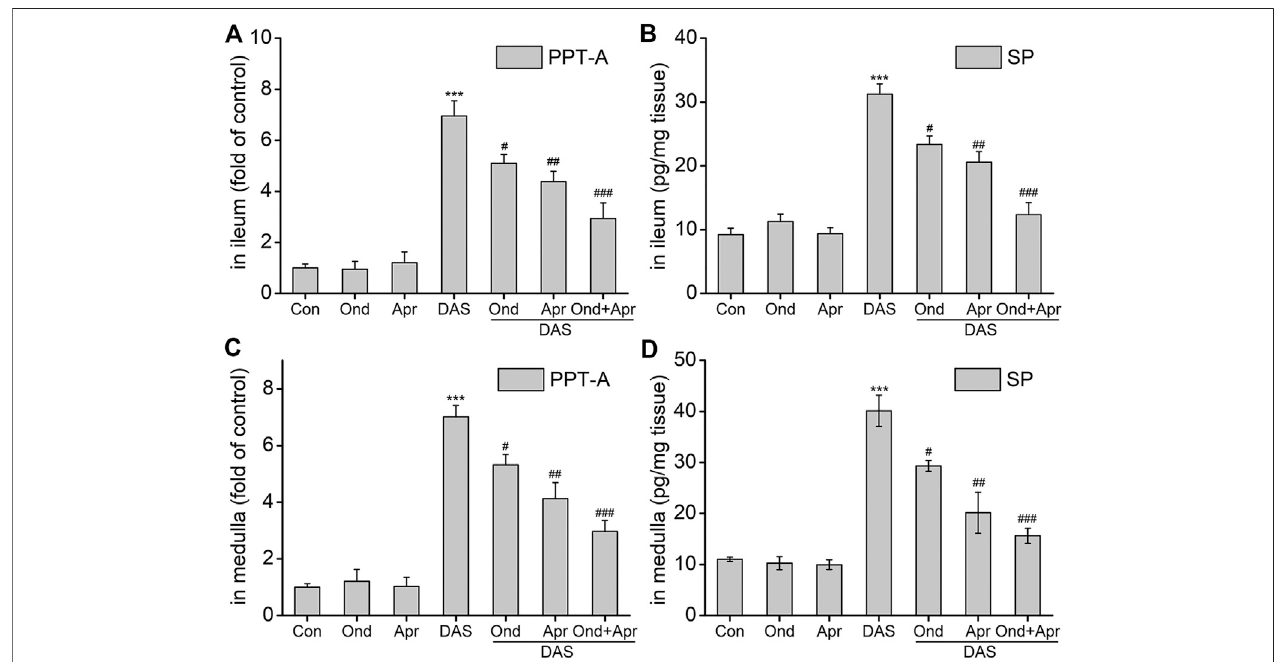
FIGURE 8 | The effect of Ond and Apr on the DAS-induced PPT-A mRNA and SP protein levels in the ileum and medulla of rats. Control: saline, p. o.; Ond: 1.66 mg/kg, p. o.; Apr: 26.2 mg/kg p. o.; DAS: 2 mg/kg, p. o. Ond and Apr were administered 30 min before DAS. The ileum and medulla were collected 4 h after treatment (A and B- ileum; D and E - medulla). PPT-A mRNA levels were detected using quantitative real-time PCR. S p concentration was detected using a commercial assay kit. The data are expressed as mean ± SEM. Statistical signi fi cance was assessed using the one-way ANOVA. * p < 0.05, ** p < 0.01, *** p < 0.001 vs. the control group, and # p < 0.05, # # p < 0.01, # # # p < 0.001 vs. the DAS